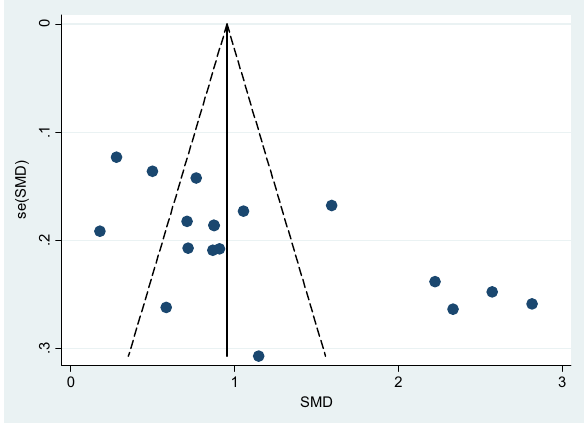
Figure 4: Begg ’ s funnel plot for serum Hcy and